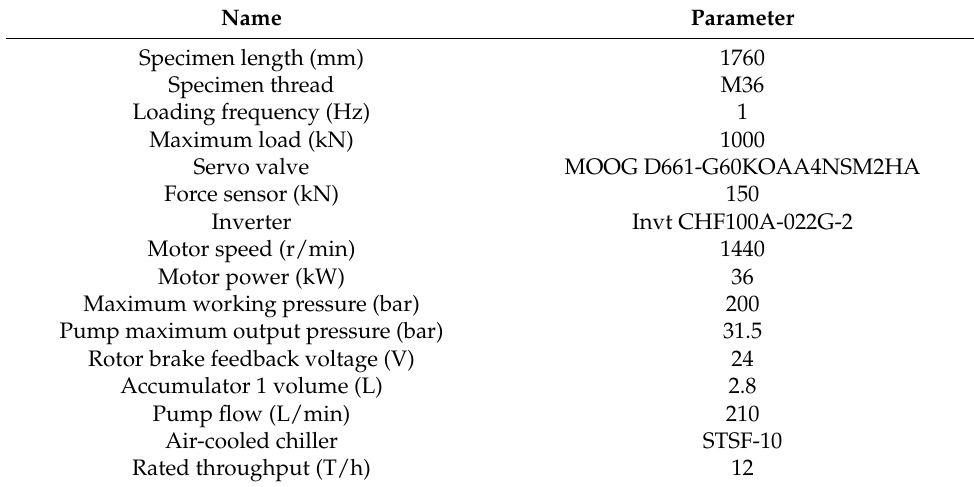
Table 3. Component test platform design